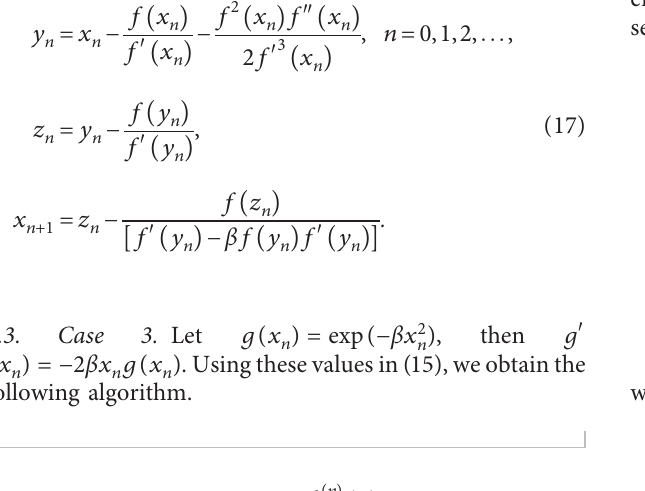
, compute the approximate 0